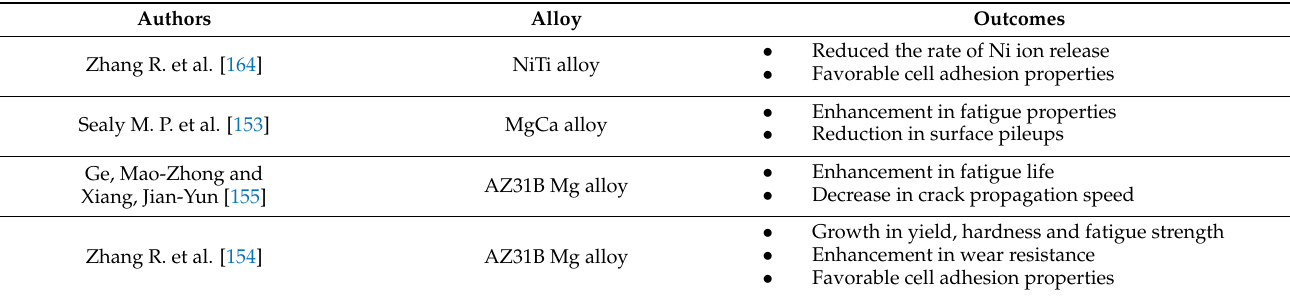
Table 10. LSP treatment on biocompatible alloys.